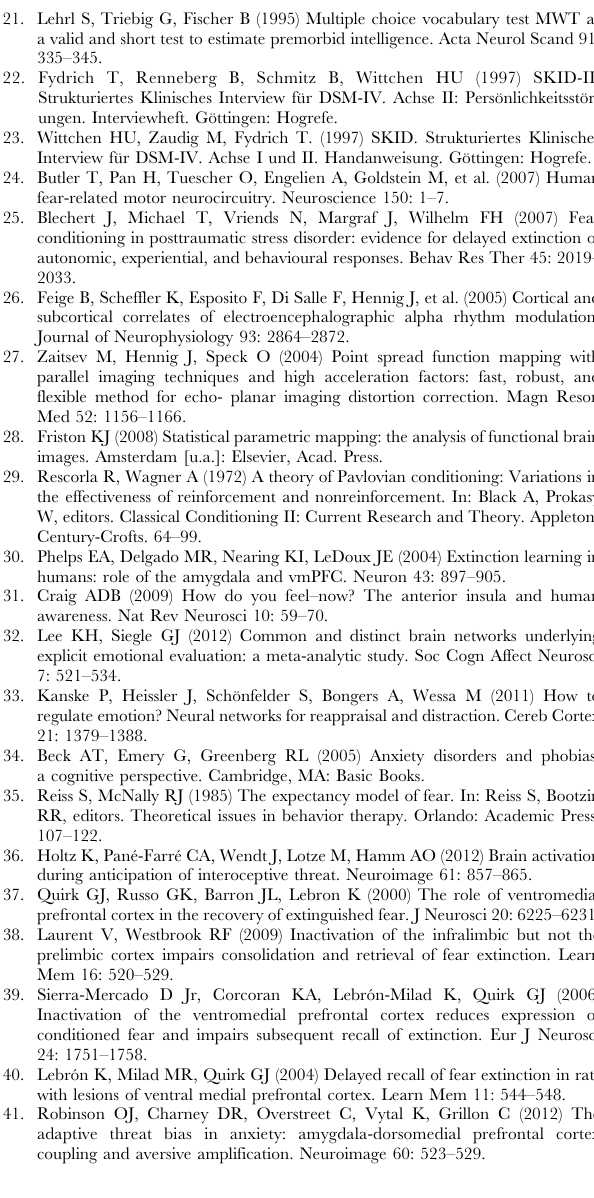
estimates from the peak voxel during all three runs (UF-Cond1, UF-Cond2, UF-Test). Error bars: s.e.m.